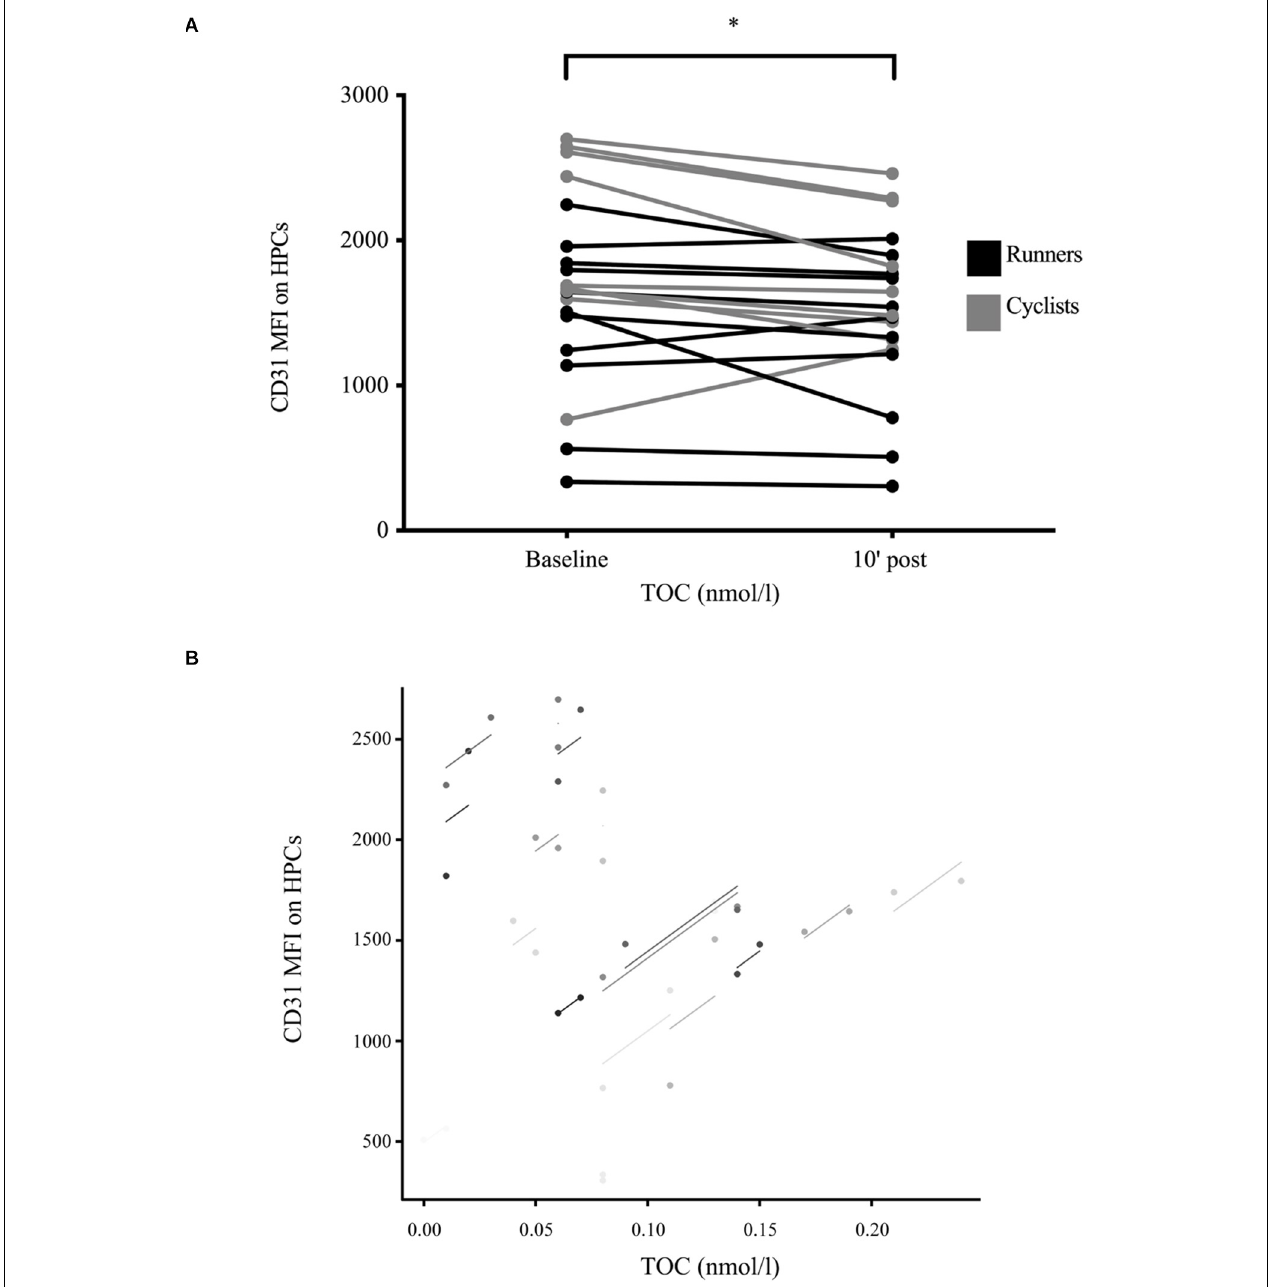
FIGURE 3 | Exercise-induced CD31 median fluorescent intensity expression on hematopoietic stem and progenitor cells in well-trained participants. (A) Median fluorescent intensity (MFI) expression of the cell surface protein CD31 on detected circulating hematopoietic stem and progenitor cells (HPCs) was assessed at baseline and 10 min after exercise cessation. Results were significantly decreased post-exercise. Color differences indicate the two different exercise modalities. n = 20. (B) Total oxidative capacity (TOC) was positively associated with CD31 MFI expression on detected HPCs ( r rm = 0.60, p = 0.005, and n = 19). Significant differences are indicated by * p < 0.050 and were assessed by mixed ANOVA with one repeated factor (time) and one group factor (exercise modality). Parameter relation was addressed by repeated measures correlation analysis.